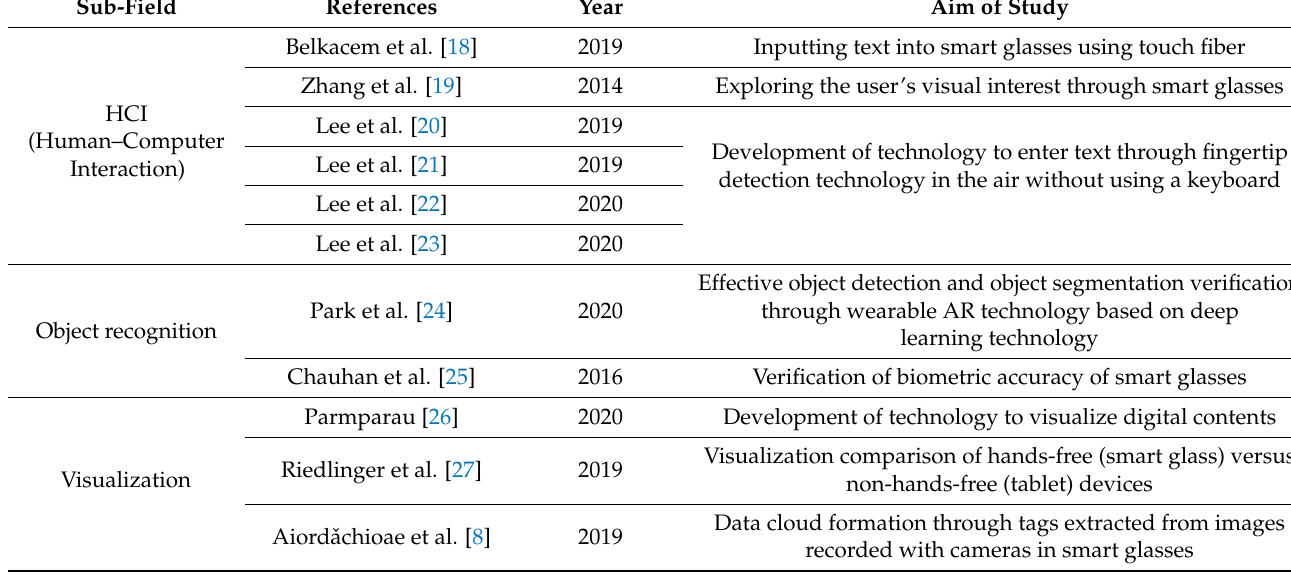
Table 1. Summary of smart glass applications in the field of computer